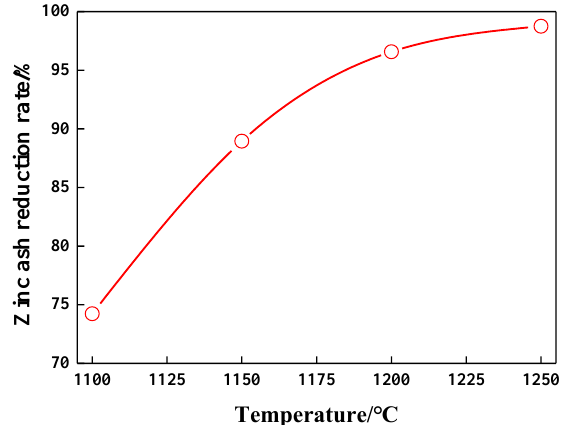
Figure 6. Effect of temperature on reduction rate of zinc oxide.